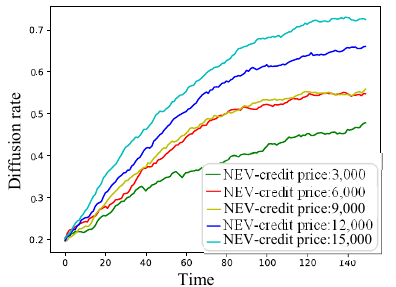
Figure 11. Affiliated rate, Small world.